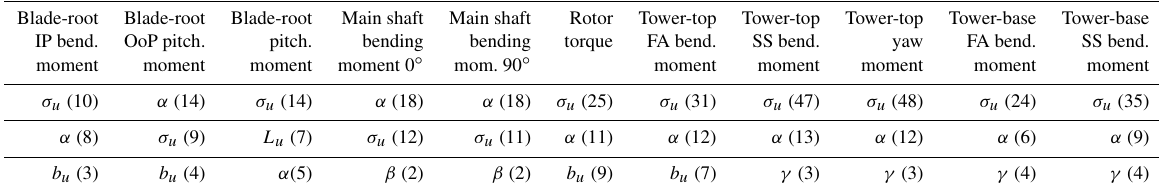
Table 5. Primary input parameters contributing to fatigue load sensitivity of each QoI. Values indicate the number of times the variable contributes to the sensitivity